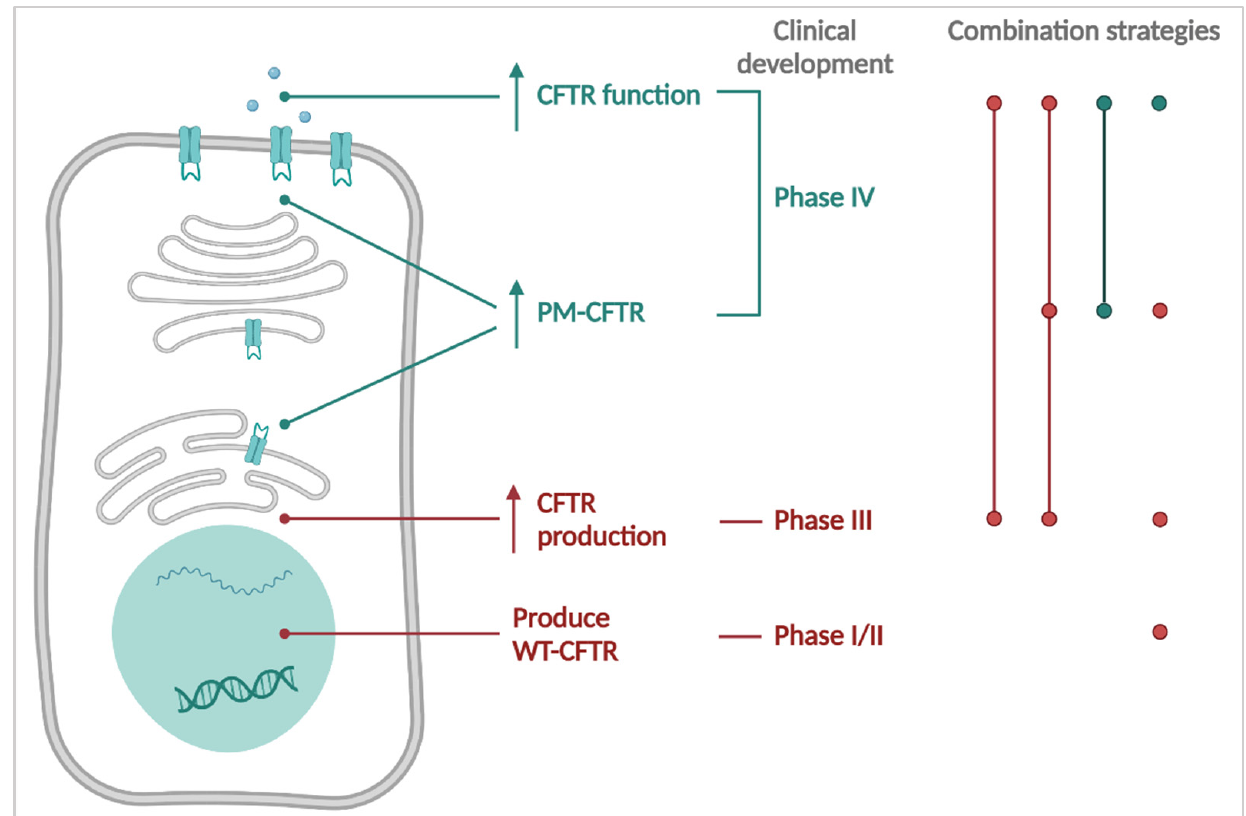
Figure 2. Global overview of therapeutic strategies for causal treatment of CF and their current progress in clinical development. On the right, strategies are represented by dots, and lines connecting them indicate combination therapies, either market-approved (green), or in clinical development (red). WT: wild-type. PM: plasma membrane.